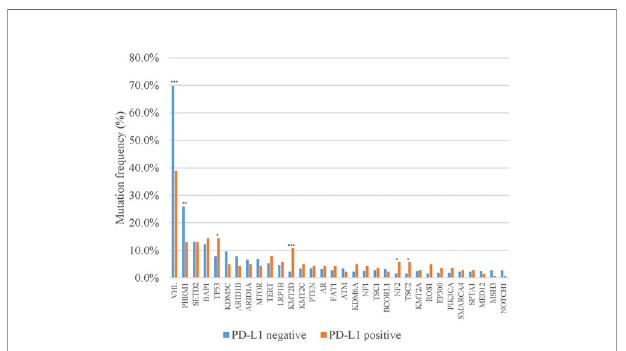
FIGURE 2 | Discrepancies of mutation frequency between PD-L1-positive and PD-L1-negative patients. *p < 0.05, **p < 0.01, ***p